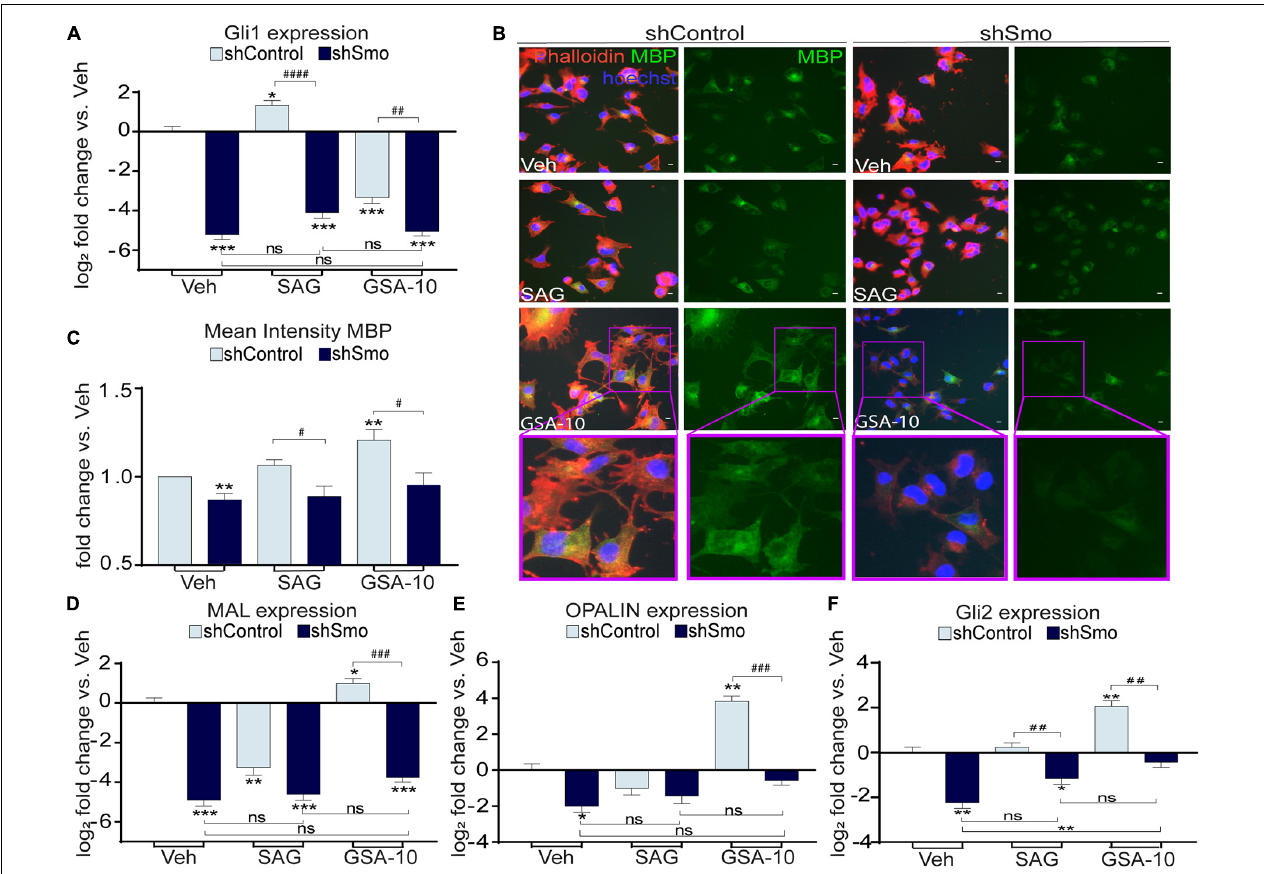
FIGURE 4 | Smo silencing decreases GSA-10-induced MBP, MAL, OPALIN, Gli2 gene expression, and abrogates GSA-10 activity in Oli-neuM differentiation. (A) Gli1 gene expression levels. Values were normalized and plotted as log2 fold change and are mean ± SEM ( n ≥ 3) with respect to vehicle shControl. (B) Representative IF images of shSmo or shControl cells under the indicated treatments and stained with anti-MBP primary and Alexa 488 secondary antibodies (green); Phalloidin (red); Hoechst (blue) = nuclei. Scale bar = 10 µ m. Cell magnifications are shown in boxed area. (C) Quantitative analyses of IF cell images. Mean intensity of MBP ± SEM ( n ≥ 3) was plotted as fold change vs. shControl vehicle. (D–F) MAL, OPALIN, and Gli2 gene expression levels. Values were normalized and plotted as mean log2 fold change vs. vehicle shControl ± SEM ( n > 3). Two-tailed paired Student’s t -test was performed for statistical significance vs. shControl vehicle (* labeled) and to compare shControl vs. shSmo (# labeled) in each treatment. One-way ANOVA with Tukey’s multiple comparison test was performed to analyze statistical significance between the different treatments. * p < 0.05, ** p < 0.01, *** p < 0.001; # p < 0.05, ## p < 0.01, ### p < 0.001, and #### p < 0.0001; ns, non